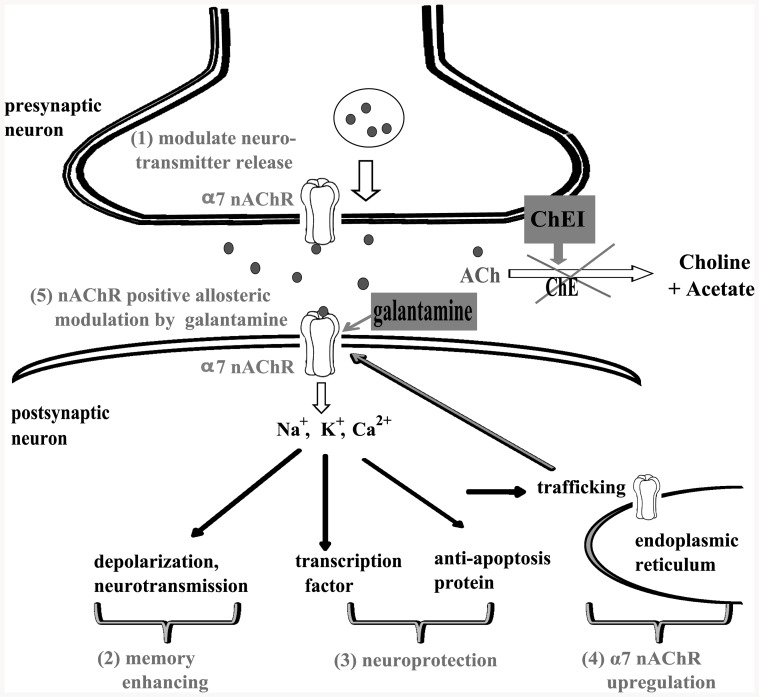
Postulated mechanism for CHRNA7 polymorphisms and ChEI cognitive response.ChEIs increase the level of acetylcholine, which binds to α7 nAChR (encoded by CHRNA7). CHRNA7 polymorphisms are postulated to affect the cognitive response to ChEIs through the following mechanisms: (1) modulation of neurotransmitter release in presynaptic neurons, (2) enhancement of memory via mediating cholinergic neurotransmission, (3) neuroprotection via α7 nAChR, (4) upregulation of α7 nAChR by ChEI, and (5) galantamine-associated positive allosteric modulation of α7 nAChR. Abbreviations: nAChR, nicotinic acetylcholine receptor; ACh, acetylcholine; ChE, cholinesterase; ChEI, cholinesterase inhibitor.